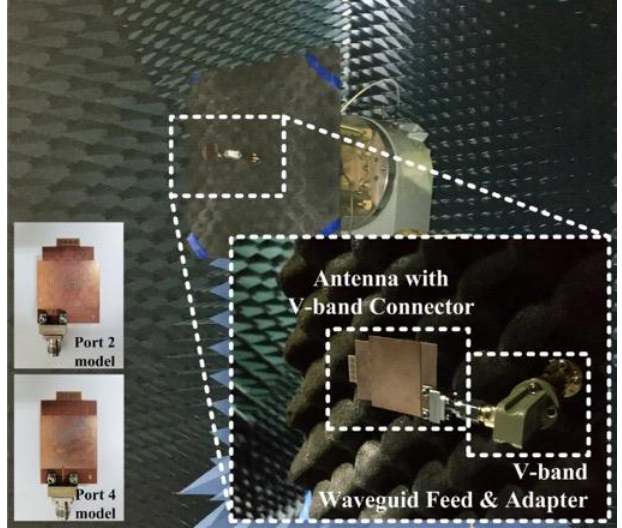
Figure 17. Fabricated antenna and measurement setup.